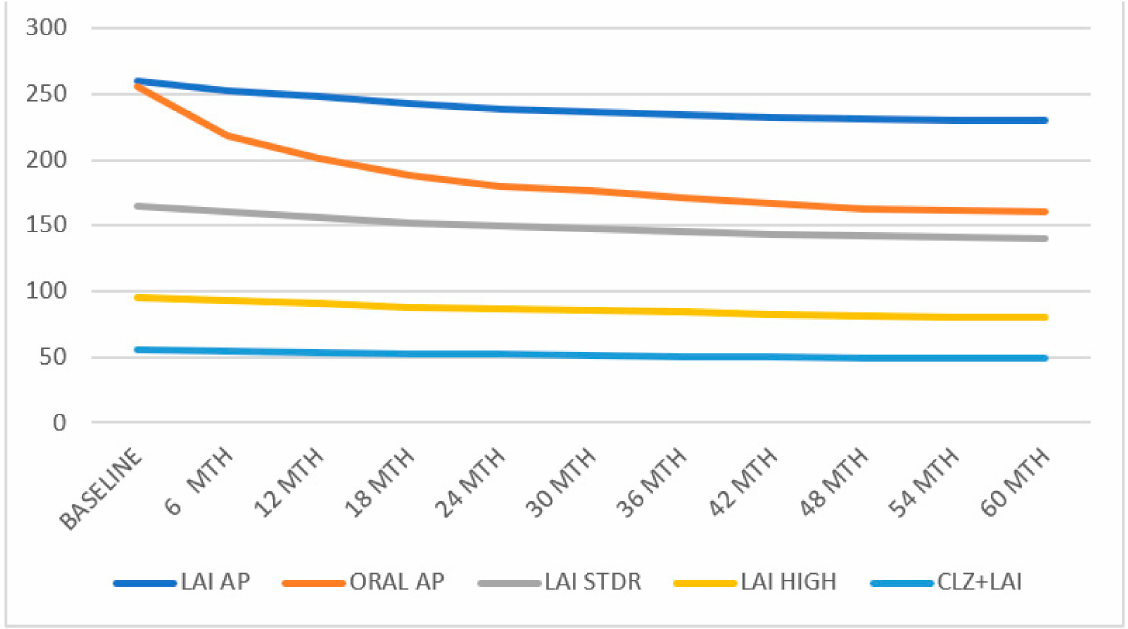
Figure 1. Treatment discontinuation, hospitalisations, and suicide attempts (%).